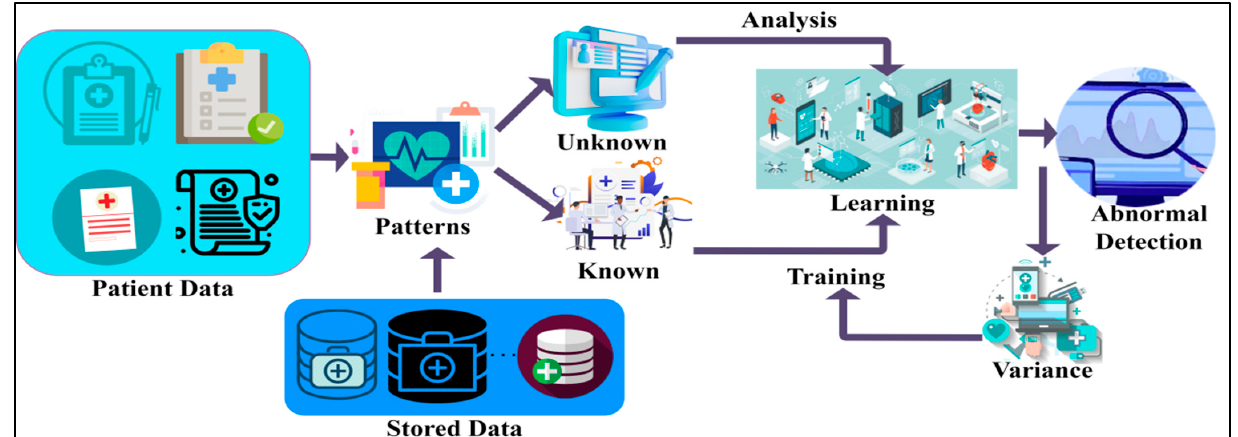
Figure 1. The proposed Syndrome-dependent Pattern Recognition Model.